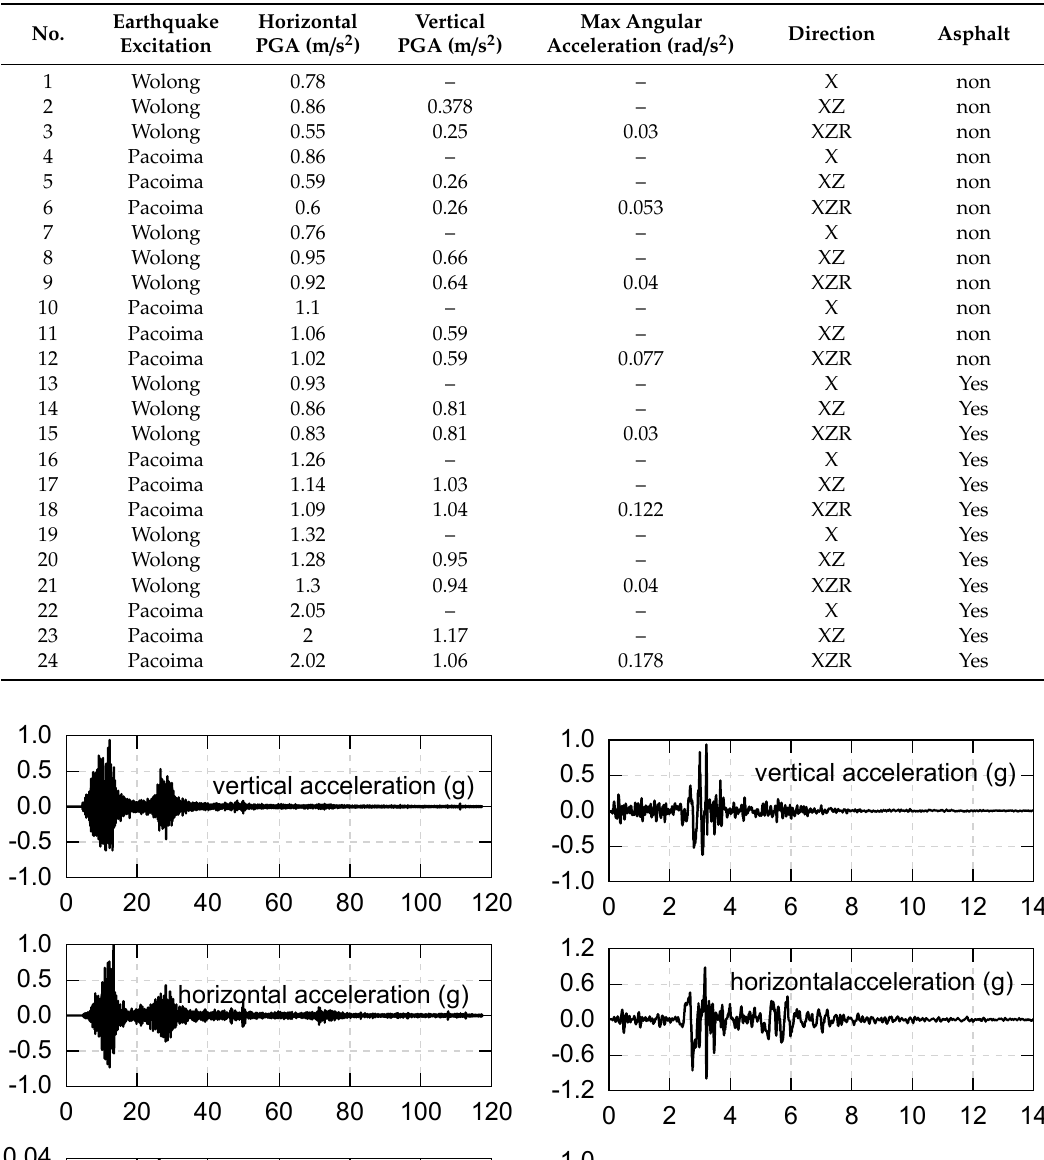
Table 2. Loading schedule of the shaking table tests.